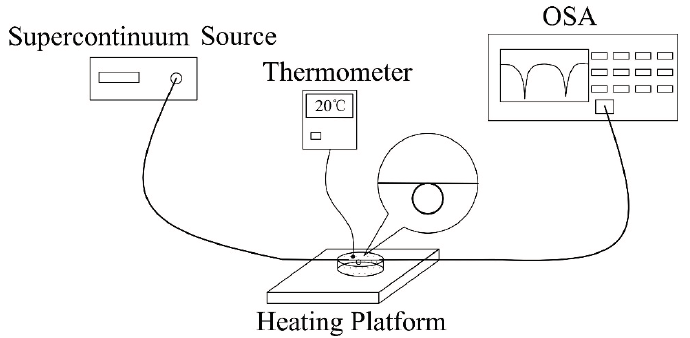
Figure 3. The schematic diagram of the experiment